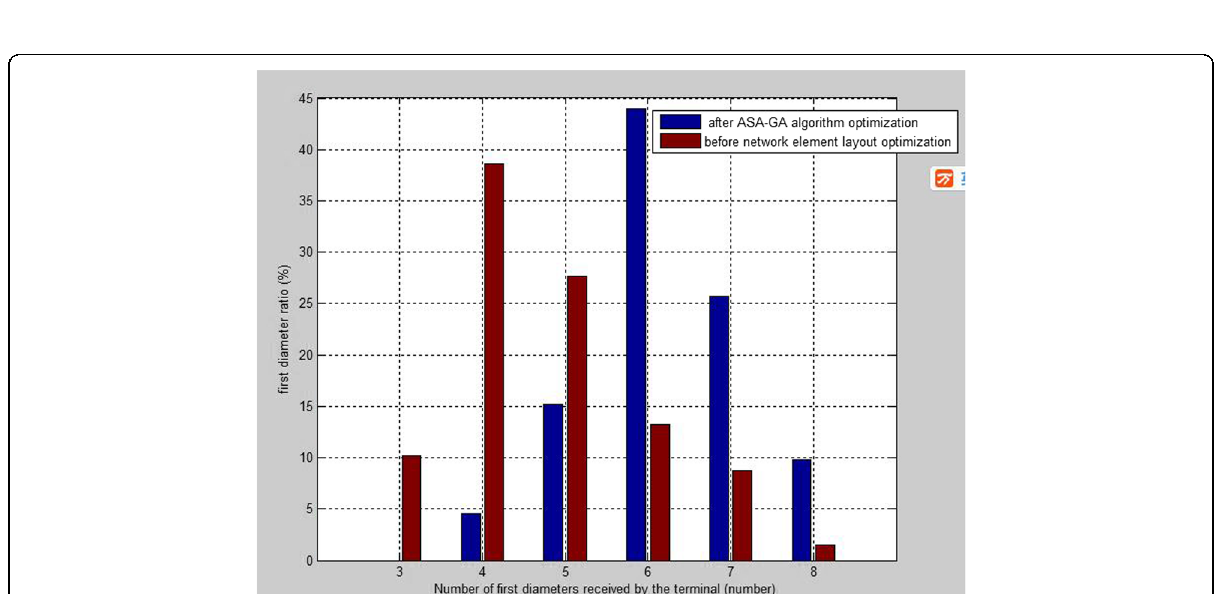
Fig. 3 The first diameter coverage statistics chart. The brown columns represent the positioning signal coverage before the layout optimization of the network element. The blue columns represent the positioning signal coverage after the layout optimization of the network